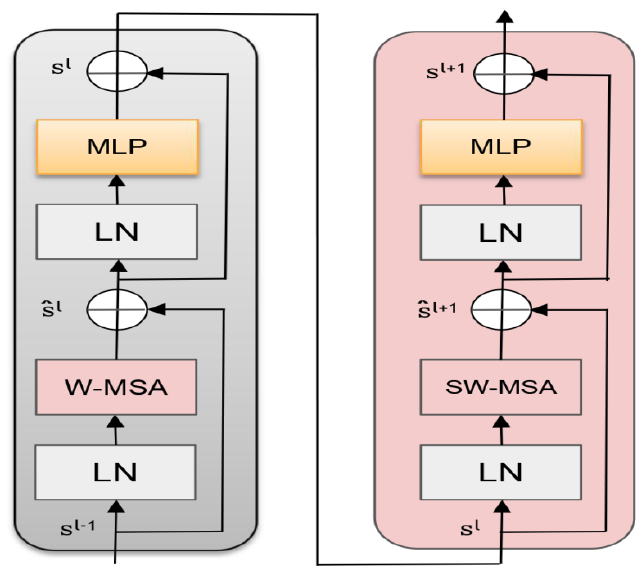
Figure 5. Two successive Swin Transformer Blocks.